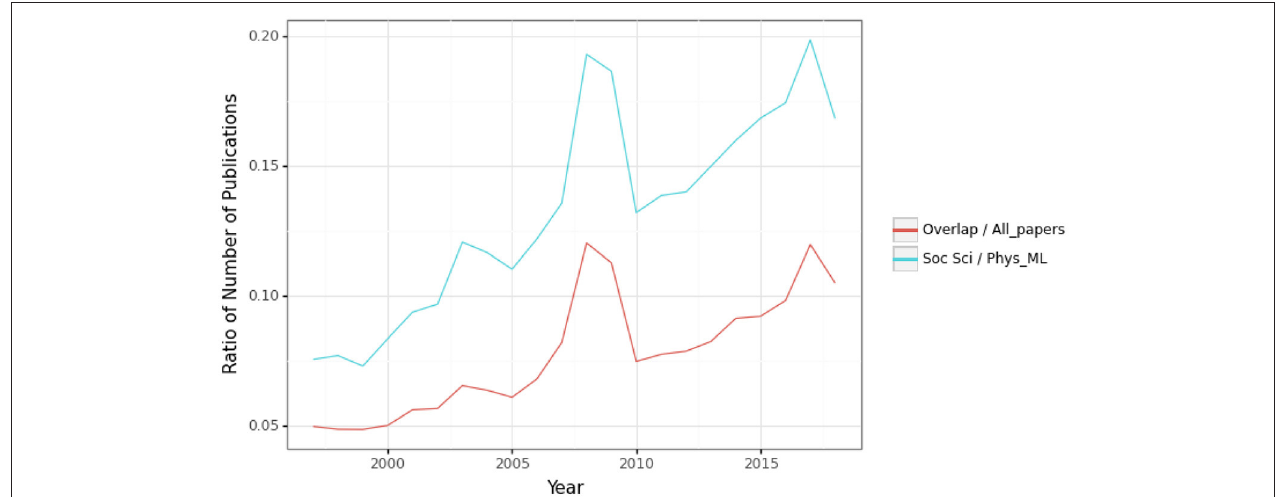
FIGURE 2 | Ratio of number of articles with social sciences keywords to number of articles with technical keywords (blue), and ratio of number of articles with both social sciences, and technical keywords to total number of articles in the dataset (red), per year.